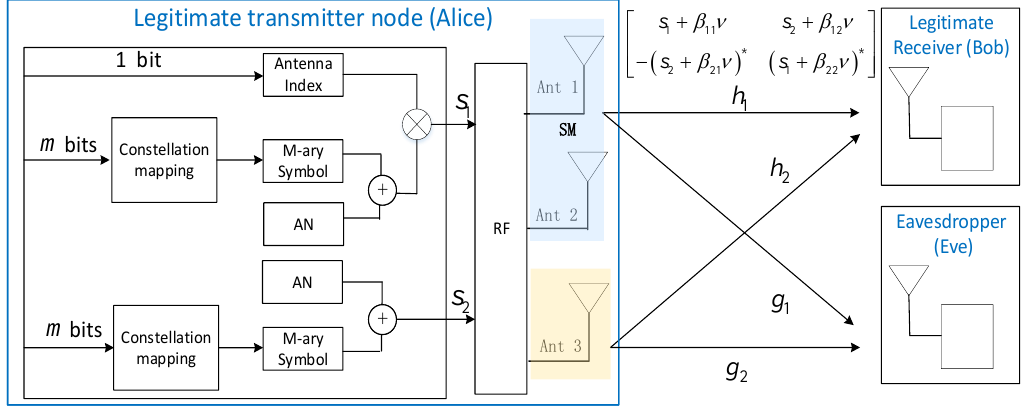
Figure 1. System model of the Alamouti-coded physical layer security (PLS) with artificial noise